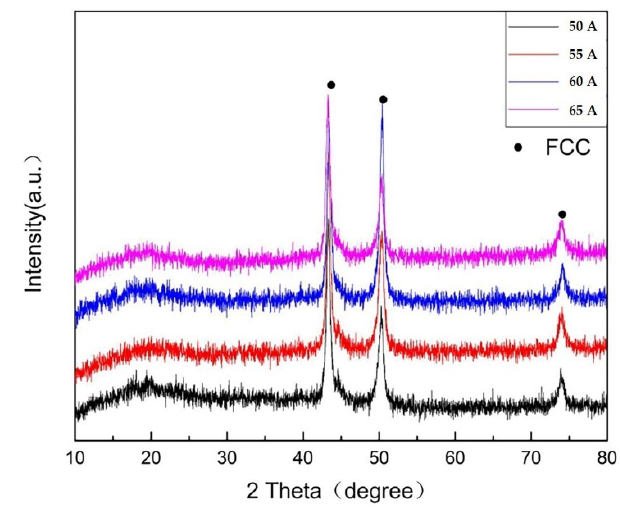
Figure 6. XRD patterns of the CoCrFeNiMn HEA coatings.